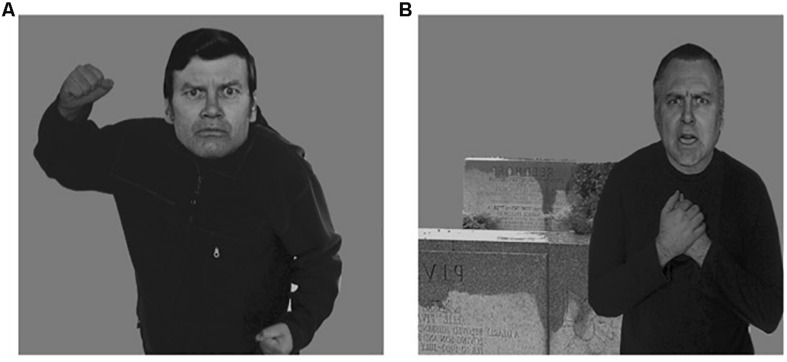
Examples of stimuli of task face-body context. (A) Trial congruent face-anger and body-anger. (B) Trial incongruent face-anger and body-sadness. Permission obtained from Aviezer et al. (2008).